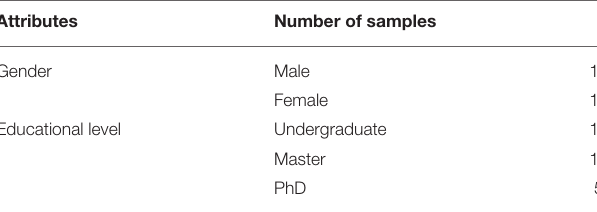
TABLE 3 | Basic information of teachers surveyed.